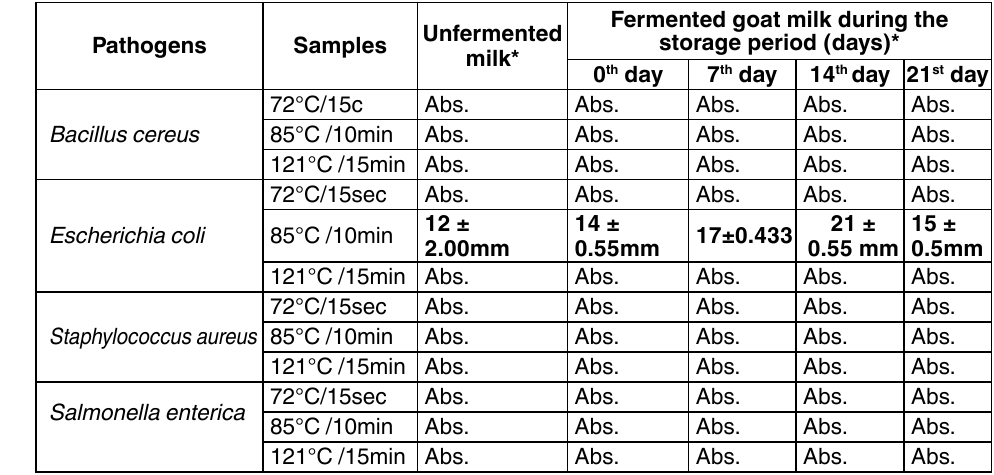
Table 1. Antibacterial activity of the skim milk of unfermented milk and WSPE of fermented milk duringstorage (inhibition zone in